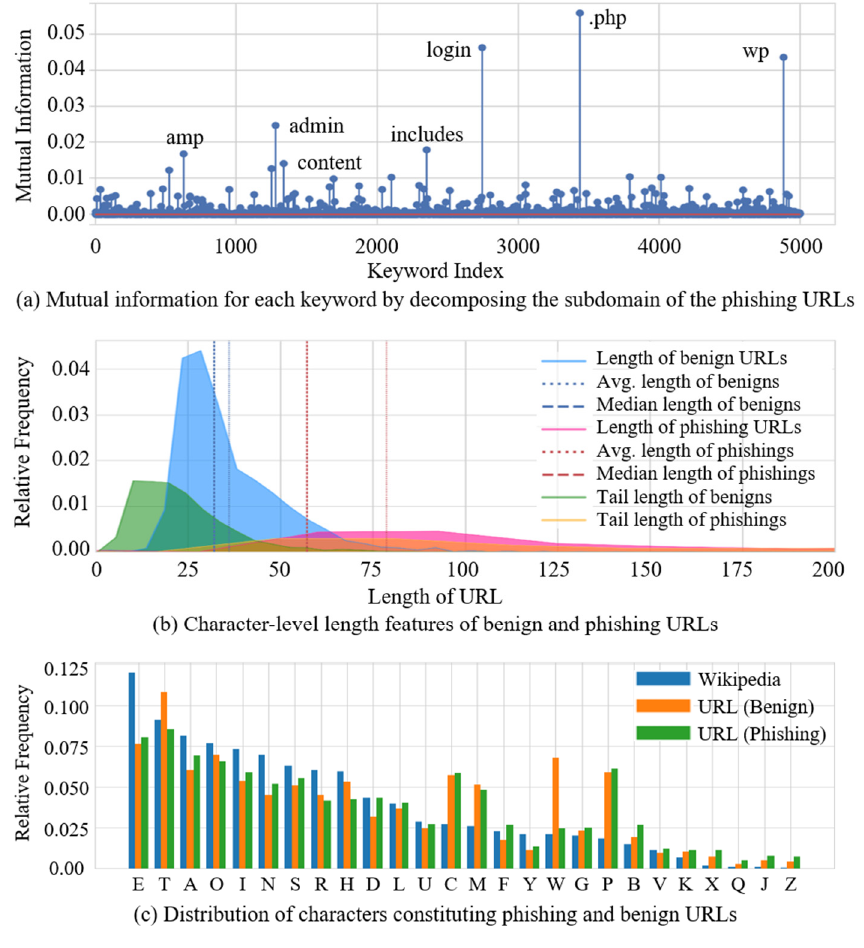
Figure 2. Three main statistics supporting the strong need for character-level modeling in the phishing URL detection task: ( a ) mutual information by keyword; ( b ) availability of the URL length feature; ( c ) character distribution that separates benign and phishing URLs.